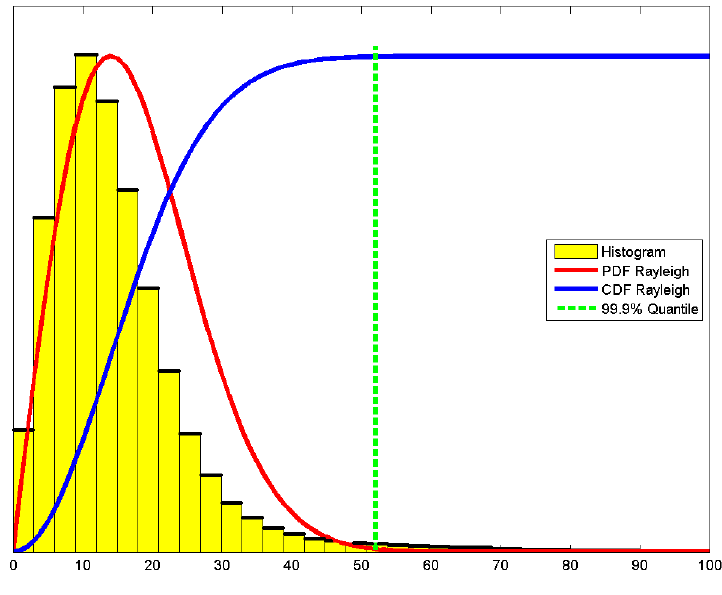
Figure 8. Histogram of the coefficient amplitudes and Rayleigh probability density (red) and cumulative density function (blue) with 99.9% quantile